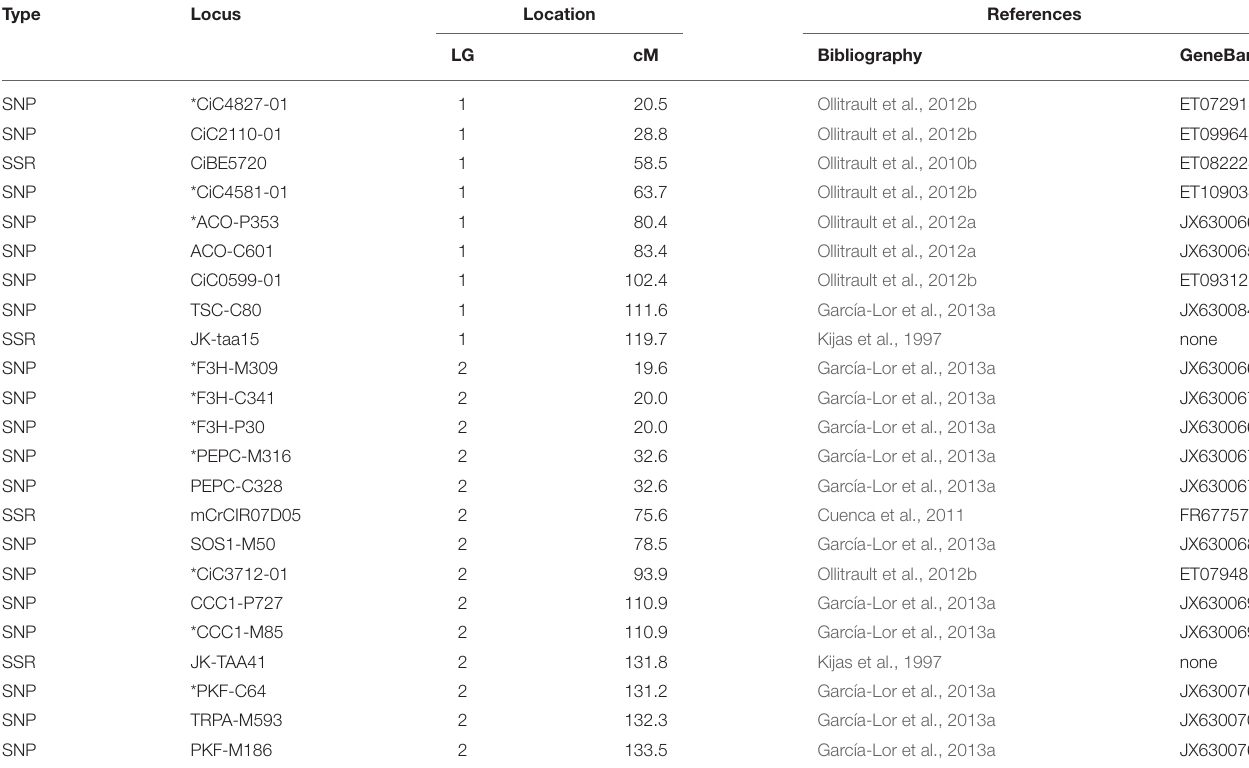
TABLE 1 | Molecular markers analyzed indicating the type of marker, locus name, linkage groups (LGs) 1 and 2 and location within LG in centimorgans (cM), bibliographic reference in the literature, and GeneBank accession.